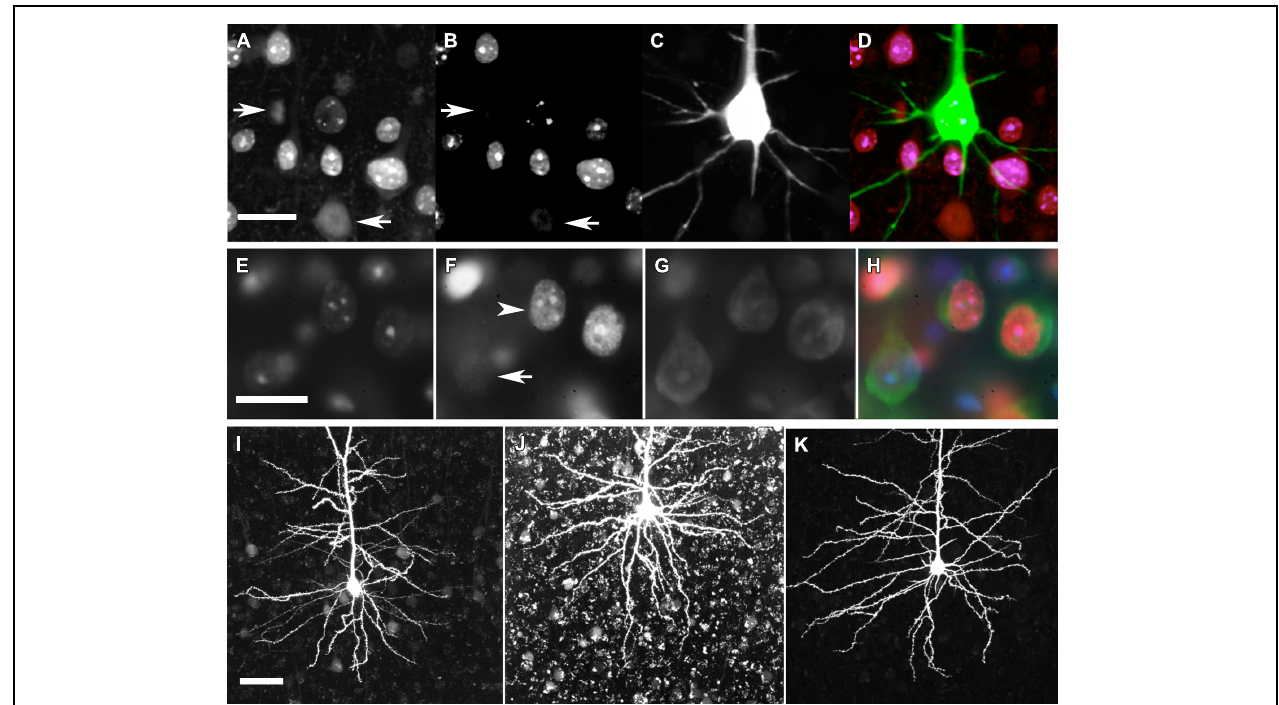
FIGURE 2 | Immunohistochemical genotyping to identify dye-filled, nuclear-, or cytoplasm-counterstained neurons for morphological comparisons. (A) C-terminal MeCP2 antibody staining appears punctate in MeCP2 + neurons and diffuse in MeCP2 − neurons (arrows). (B) N-terminal MeCP2 staining appears punctate in MeCP2 + neurons, and is absent in MeCP2- neurons (arrows). (C) Alexa Fluor 594 (AF594) iontophoretically injected into lightly fixed neurons fills the cell body and dendrites. (D) Composite image of A–C . Pink = MeCP2 + , red = MeCP2 − ; in composite image the AF594 fluorescence obscures the punctate nuclear MeCP2 + staining that can be seen in panels A and B which show filled neuron is wild-type). Scale bar = 20 µ m. (E) DAPI nuclear labeling reveals which cells are in the in focal plane and delineates the boundary of